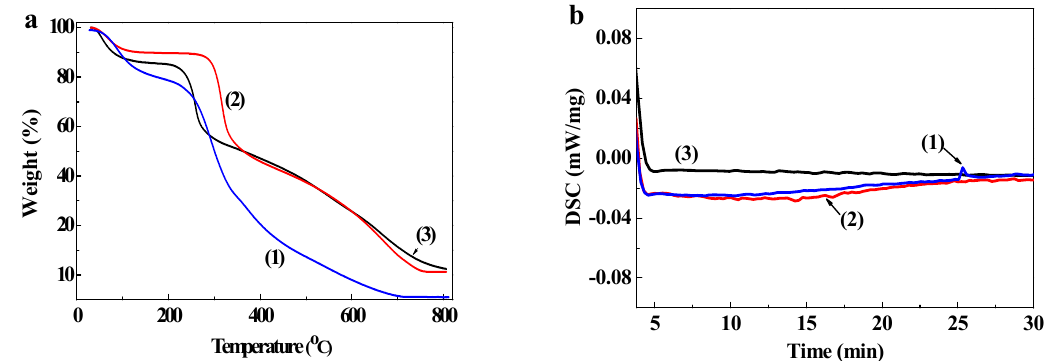
Figure 4. ( a ) Thermogravimetric analysis (TGA) of (1) chitosan, (2) AmCS, and (3) FA-AmCS-TPP nanoparticles; ( b ) DSC of (1) chitosan, (2) AmCS, and (3) FA-AmCS-TPP nanoparticles at constant 37 °C.